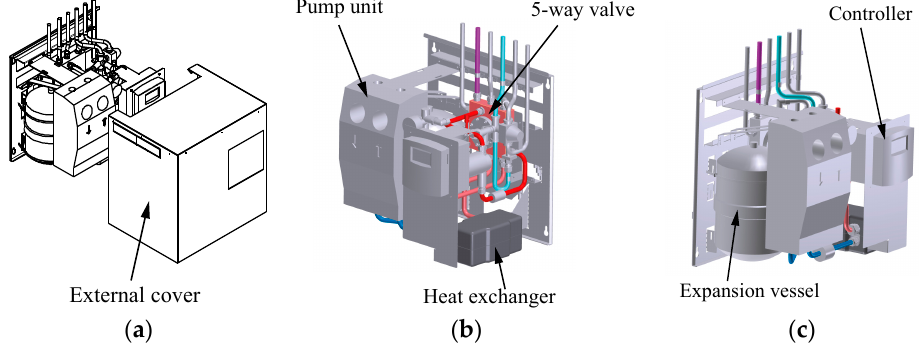
Figure 4. Prototype drawings of the connecting unit excluding the auxiliary heater: ( a ) with the external cover; ( b ) without the external cover in perspective; ( c ) without the external cover in another perspective.